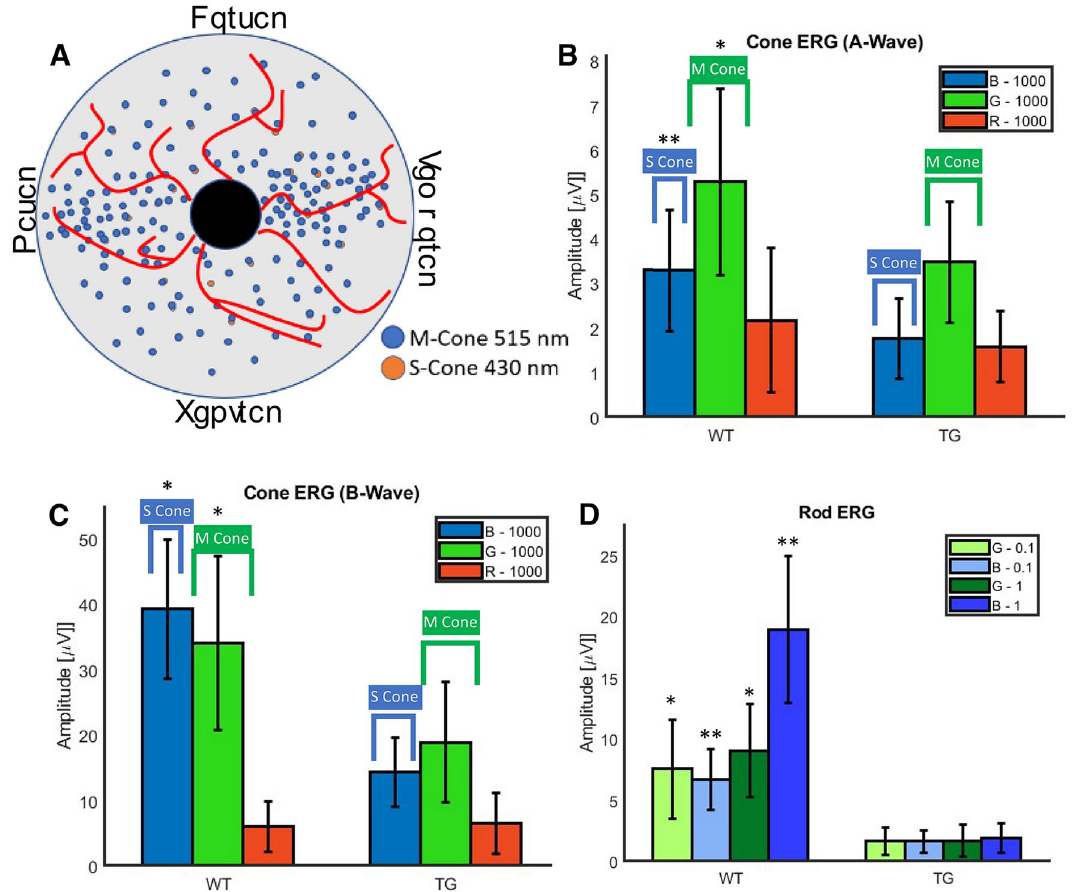
Figure 7. Quantitative comparison of OCT guided micro-focal ERG measurements with multiple stimulation wavelengths in wild type and transgenic pigs. ( A ) Top: schematic of distribution of S and M cones in pig retina. ( B ) Quantitative comparison of A-wave amplitude of micro-focal ERG of S and M-cone photoreceptors stimulated by blue (B, 450 nm) and green (G, 520 nm) focused laser beam in wild type (WT) and transgenic (TG) pigs at light intensity 1000 (cd s/m 2 ). ( C ) Quantitative comparison of B-wave amplitude of micro-focal ERG of S and M-cone photoreceptors stimulated by blue and green focused laser beam in WT and TG pigs at light intensity 1000 (cd s/m 2 ). Red (638 nm) micro-focal stimulated ERG in WT and TG pigs shows roughly noise level amplitude only at 1000 (cd s/m 2 ) indicating absence of L-cones. ( D ) Quantitative comparison of B-wave amplitude of micro-focal ERG of rod photoreceptors stimulated by blue and green focused laser beam in WT and TG pigs at different light intensities 0.1 and 1 (cd s/m 2 ). N = 8 eyes/group. Graphs presented as mean ± SD, significance denoted by * P < 0.01 and ** P < 1E − 5 between wild type (WT) and transgenic (TG)